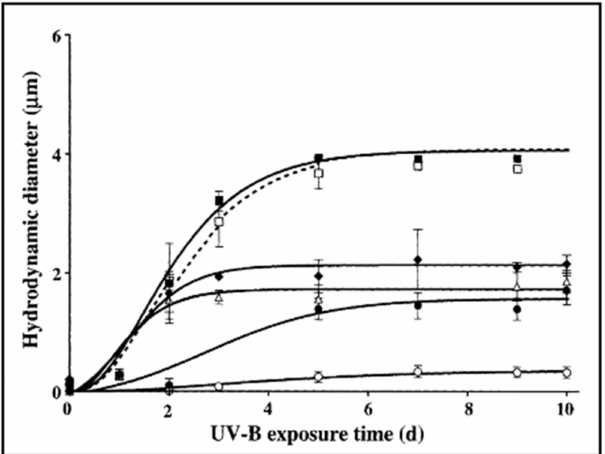
Figure 28. In these experiments, six aliquots of 0.2 µ m-filtered SW were UV irradiated for a pro- gressively longer time, and then DOM was set to self assemble under continuous monitoring of particle size Dynamic Laser Scattering. Control not irradiated DOM (filled squares) or irradiated for 24 h at 10 W m 2 with UV-A light ( λ = 230–400 nm (open squares). Samples of DOM irradiated at 500 mW m 2 with UV-B ( λ = 280–315 nm) for 30 min (filled diamonds) 1 h (open triangles) 6 h (filled circles) or 12 h (open circles). Results reveal that the DOM polymer assembly in non-irradiated or samples by UV-A follows the typical second-order kinetics described in Chin et al. [2]. However, as UV polymer cracking of DOM polymers increases with time of exposure to UV-B, DOM assembly and gel formation slow down, equilibrium size of the microgels size decreases, and finally, assembly virtually fails in DOM exposed to UVB for 12 h. Data points correspond to the mean ± s.d of 30 DSL